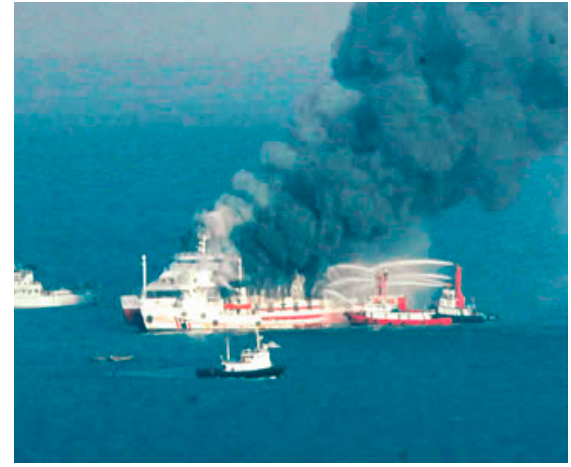
Figure 12. Two fire boats engaged in the firefighting of the M/V Liaohai.